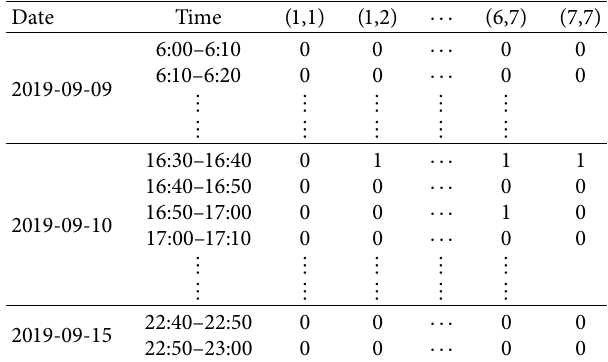
Table 5: Traffic status statistics for all